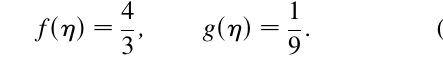
=%r FIG. 20. (Color) Ratio of %r as a function of (cid:24) for breathing (upper row) and quadrupole (lower row) mode launches at the x y 0 axial midpoint of a focusing-in- x quadrupole in a FODO ( # (cid:1) 1 = 2 ) lattice. Both launch conditions have %r 0 (cid:1) 0 : 2 (left column) and (cid:24)=(cid:24) (cid:1) 0 : 5 (right column) and the indicated values of (cid:31) shown for (cid:24)=(cid:24) 0 0